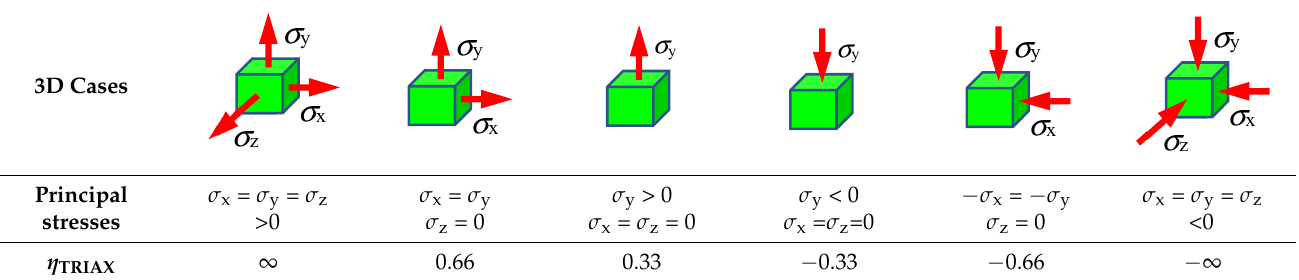
Table 4. η TRIAX values for selected 3D cases [3].